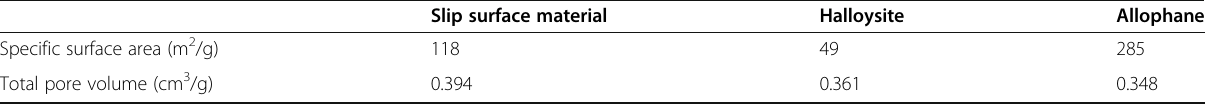
Table 1 Specific surface area and total pore volume of the slip surface material, standard halloysite, and